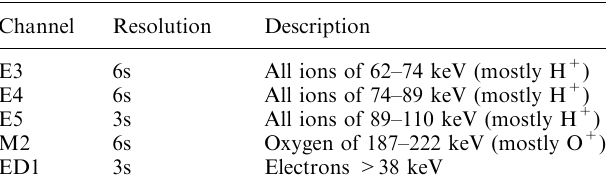
Table 1. EPIC/ICS channels Channel